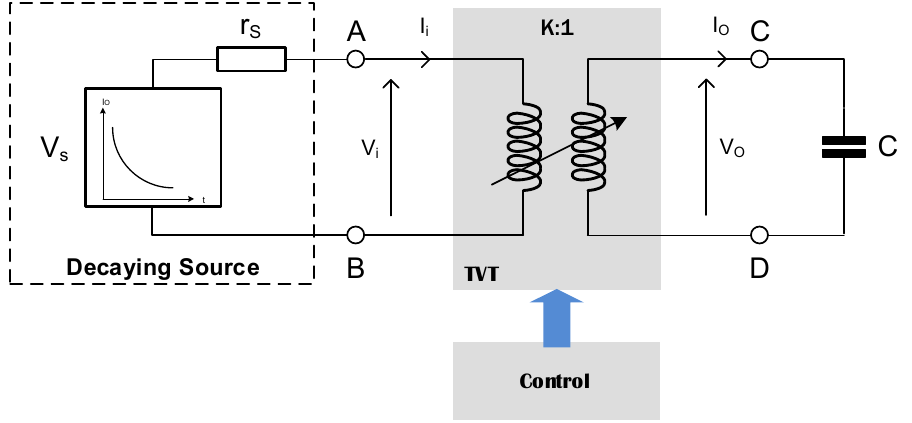
Figure 14. Decaying source matched to capacitive storage by means of a TVT.